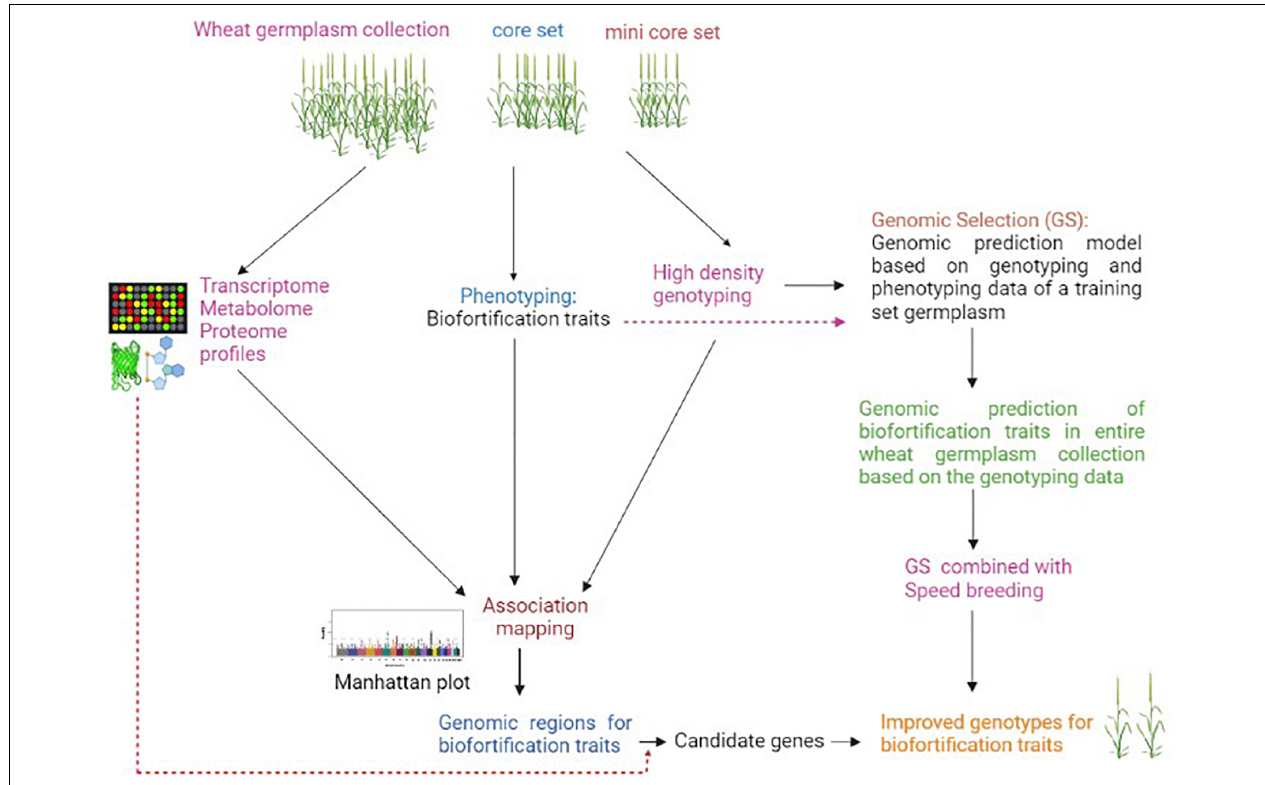
FIGURE 1 | Scheme for integration of omics and genomic selection approaches for accelerating improvement of biofortification traits in wheat.